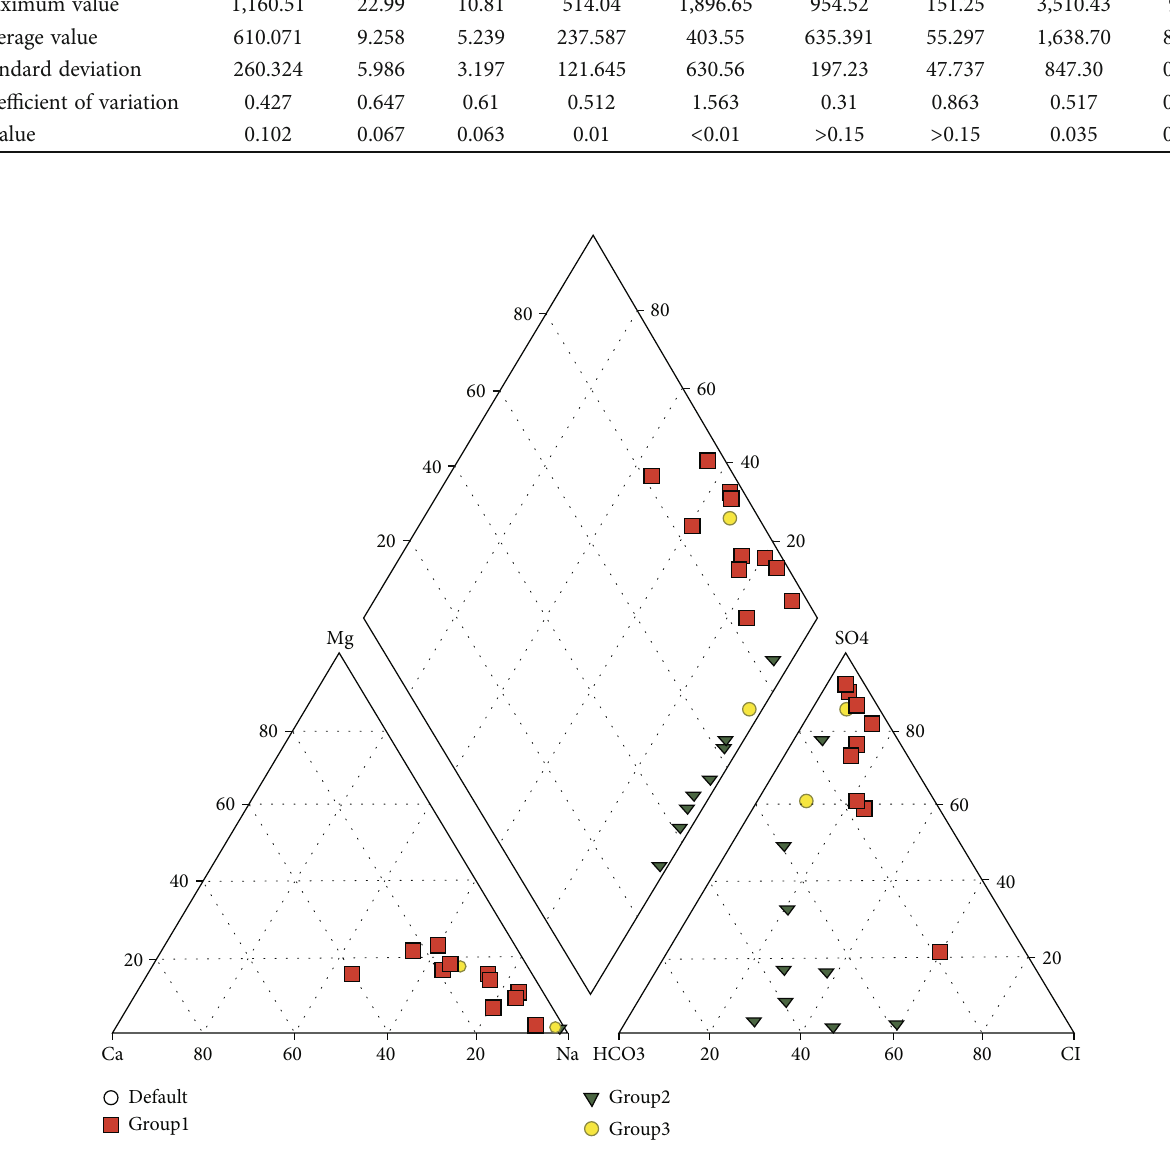
Figure 3: Piper diagram (group 1 and group 2 are, respectively, fourth aquifer and sandstone water, and group 3 is the water of air way and drainage